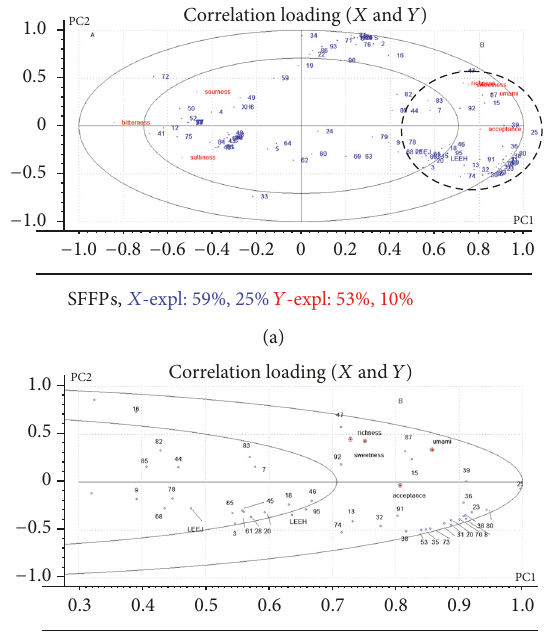
Figure 5: (a) Correlation loadings plot for sensory attributes ( 𝑌 - matrix) and GC-MS data ( 𝑋 -matrix), PC1 versus PC2. Significant variables are marked with circles. Ellipses show 𝑅 2 = 50% and 100%, respectively. (b) Enlargement of the ellipse (dashed line) labeled in (a). The Arabic numbers marked for 𝑋 variables correspond to the volatile compound names in Table